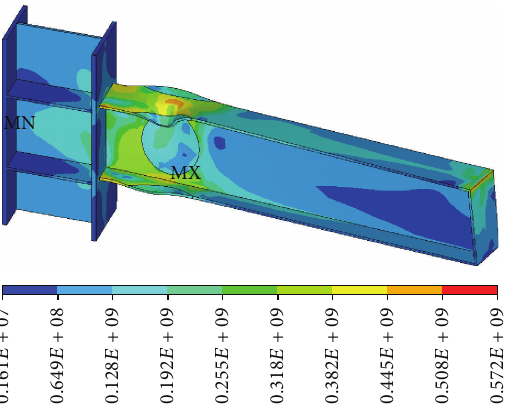
Figure 16: Stress of replaceable connection 3.